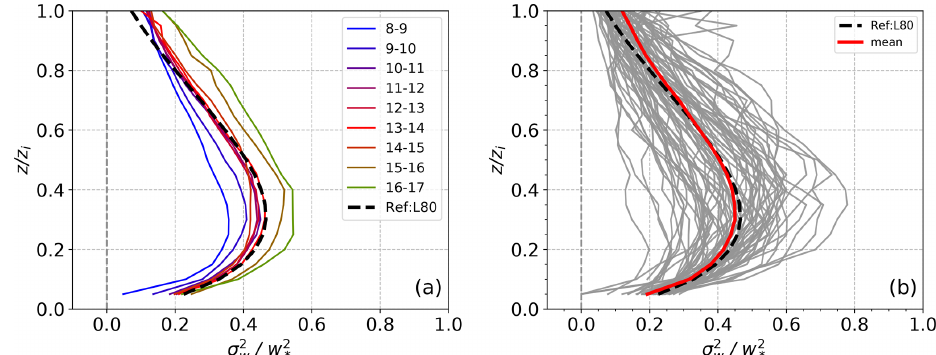
Figure 7. (a) Diurnal change of the composite hourly profiles of σ 2 w /w 2 ∗ from clear-sky and cloud-topped days combined and (b) daily profiles of σ 2 w /w 2 ∗ showing individual days (grey line) and the mean profile (red line). The universal profile of Lenschow et al. (1980) is given as a dashed black line.